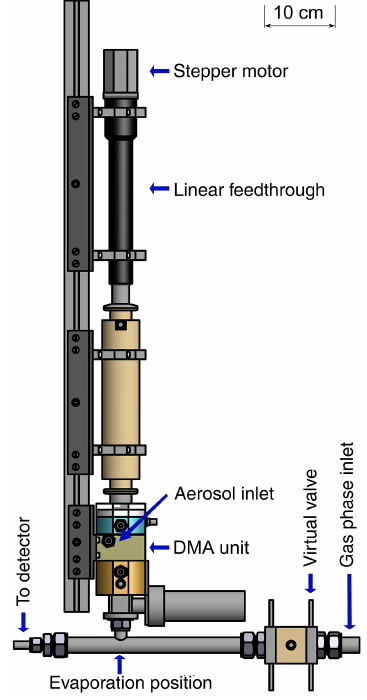
Figure 10. The TD-DMA coupled to a gas-phase detectors inlet